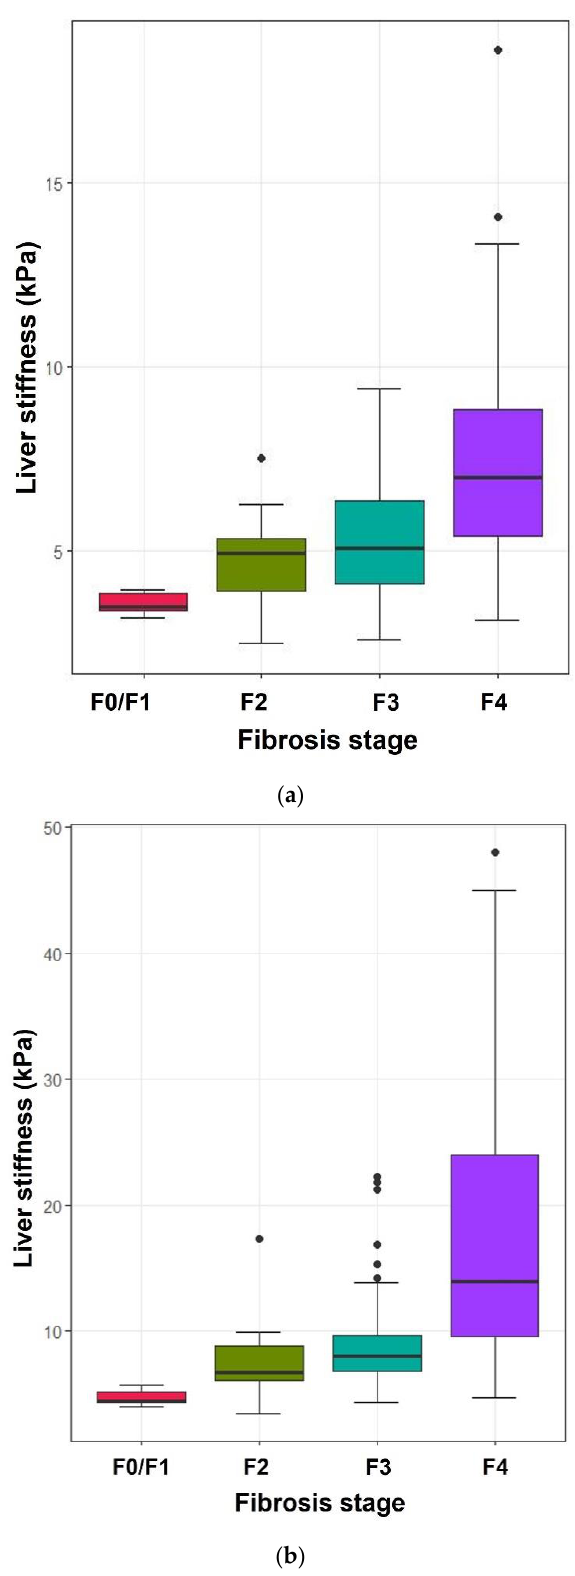
Figure 3. Box-and-whisker plot of ElastPQ and TE at each fibrosis stage. The boxes represent the interquartile range and the thick lines within the boxes represent the median values measured using ElastPQ ( a ) and TE ( b ). The error bars indicate the smallest and largest values within 1.5 box lengths of the 25th and 75th percentiles, respectively. The dots are outliers representing very large values that significantly deviate from the range of observed data.